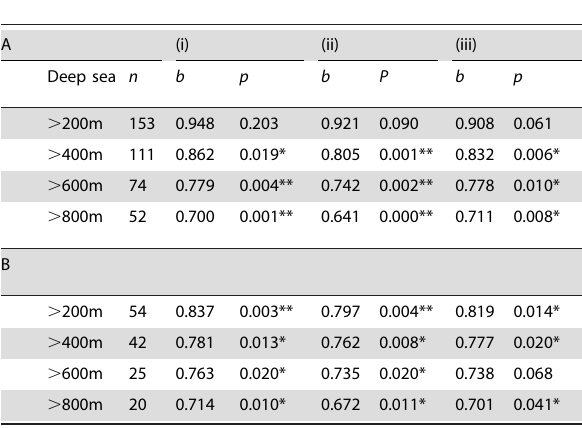
Table 1. Deep-sea gastropod body size evolution.